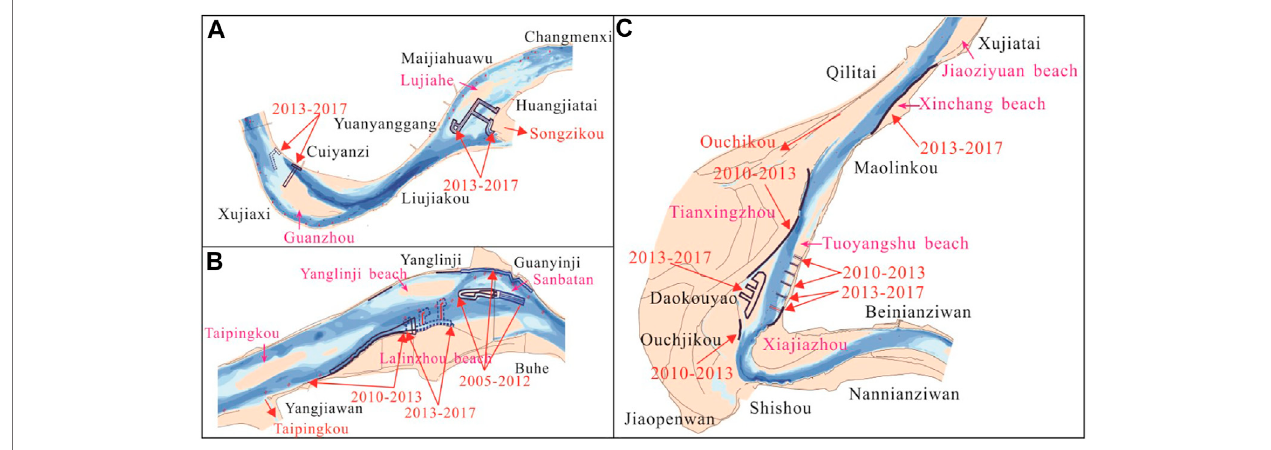
FIGURE 2 | Waterway regulation project; (A) Zhicheng – Changmenxi reach; (B) Taipingkou reach; (C) Tianxingzhou – Ouchikou reach.